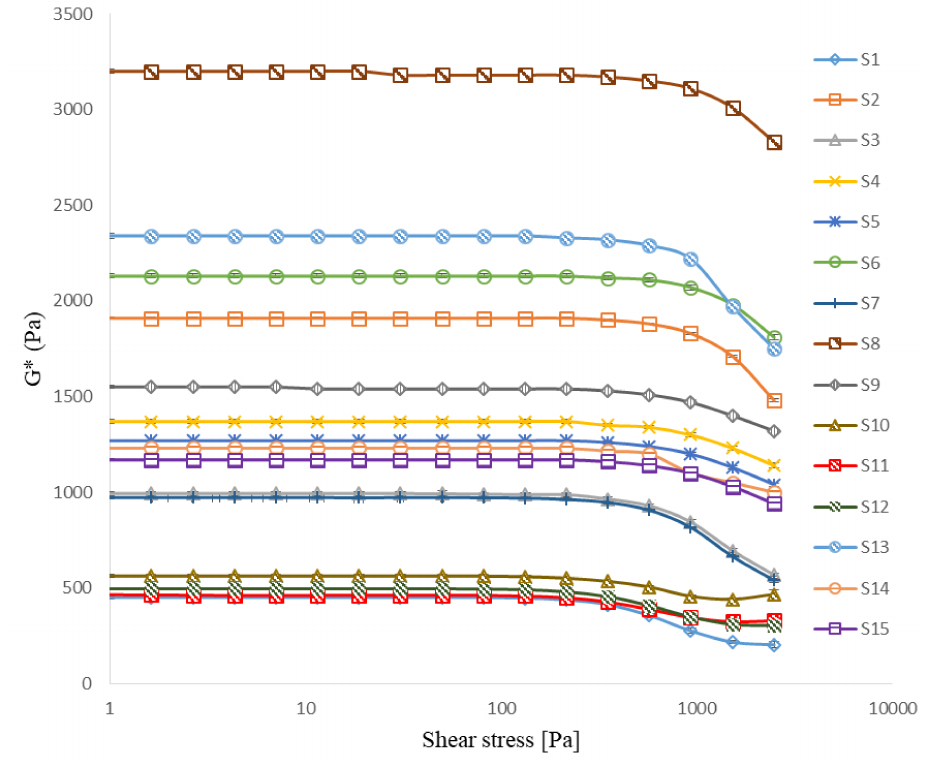
Figure 2. G* as a function of shear stress for felbinac cataplasm